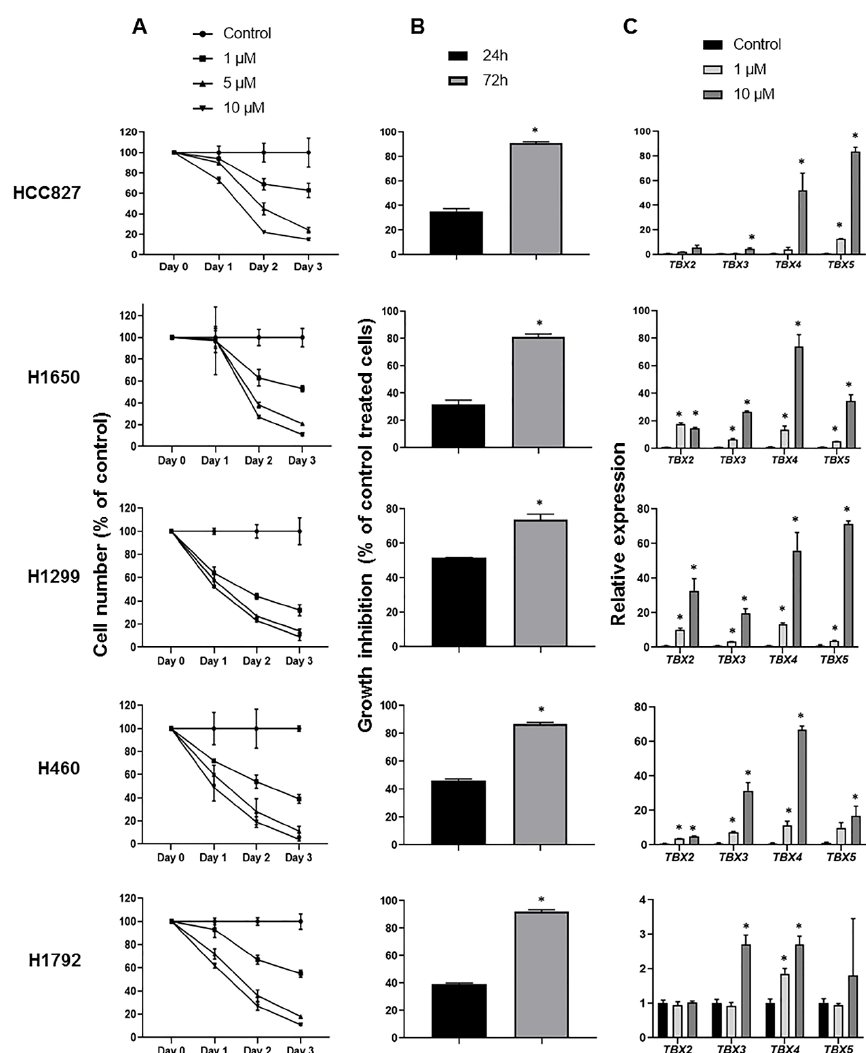
Figure 5. Augmented expression of the TBX2 subfamily in NSCLC cell lines treated with the DNA methyltransferase 5-azacytidine. ( A ) 3-(4,5-dimethylthiazol-2-yl)-2,5-diphenyltetrazolium bromide (MTT) assays were performed to assess cellular proliferation as described in Section 4. Cells were seeded in 96-well plates, at varying seeding densities following optimization, and treated with differing doses of Aza or dimethyl sulfoxide (DMSO) as control for 24, 48 and 72 h. Aza treatment was prepared and replenished every day as per previous reports [14]. Cell numbers (% of control) were determined by MTT assays and represent percentages of absorbance readings from Aza-treated cells (at each dose) versus DMSO-treated cells. Data depicted represent means ± standard deviations. ( B ) The same NSCLC cell lines were seeded in 96-well plates and treated according to IC50s (1 µM) for 24 h and 72 h. Assessment of growth inhibition was performed using the trypan blue dye exclusion method as detailed in Section 4. Growth inhibition was calculated according to the following formula: 100 − (treated/non-treated) × 100). Data depicted comprise the means ± SEM of two independent experiments (* p < 0.05). ( C ) Messenger RNA expression levels of all four members of TBX2 subfamily in control and Aza-treated NSCLC cell lines (triplicates) were analyzed by qRT-PCR using the 2 − ∆∆ C t calculation method by normalization to GAPDH and are presented as mean ± SEM (* p <